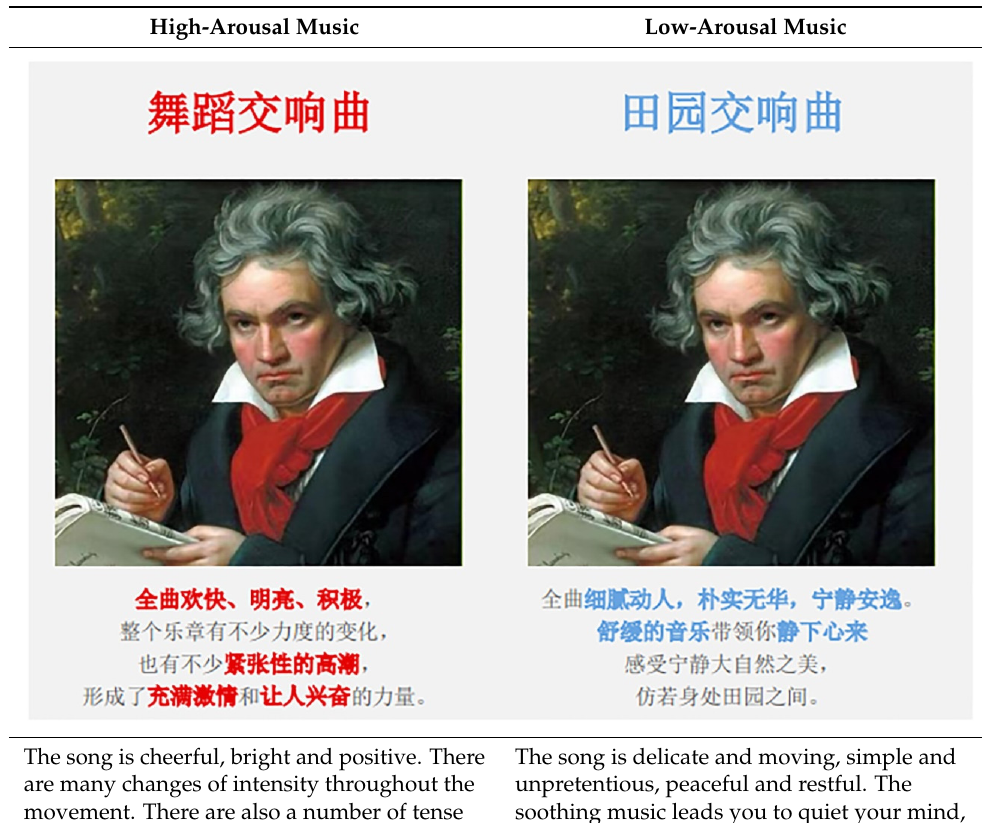
Table A2. Arousal music stimuli used in Study 2.